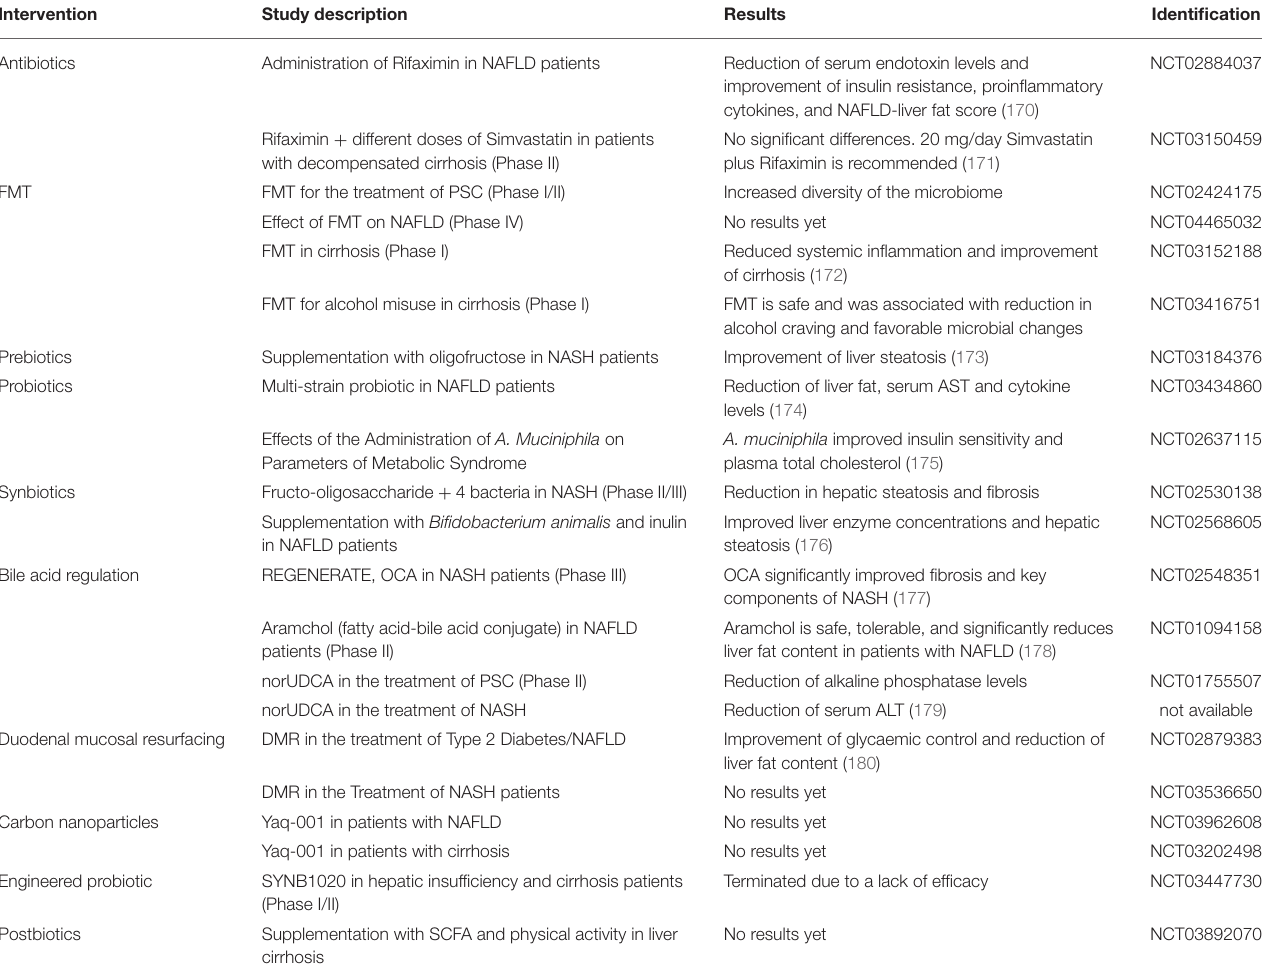
TABLE 3 | Selected clinical trials targeting the gut-liver-axis for the treatment of liver diseases. Intervention Study description